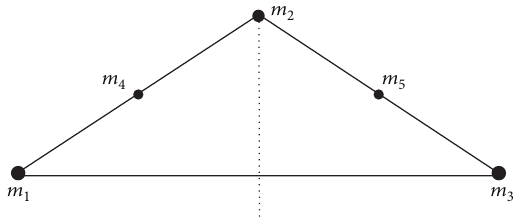
Figure 7: An impossible triangular five-body